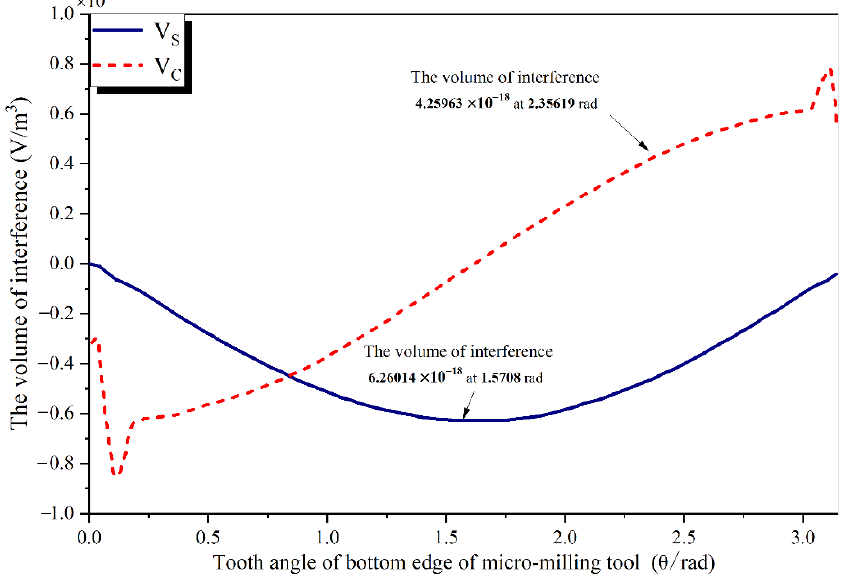
Figure 17. Decomposition of interference volume in plough area. Assume that the maximum cutting layer area corresponds to the axial force peak value. Figure 18 shows the results obtained from the studies of maximum cutting layer area corresponds to the z-direction cutting force peak value when the tooth angle at the bottom of the blade is 1.6085 radian. Where, A a = 5.8904 × 10 − 11 m 2 , V a = 5.9305 × 10 − 18 m 3 .